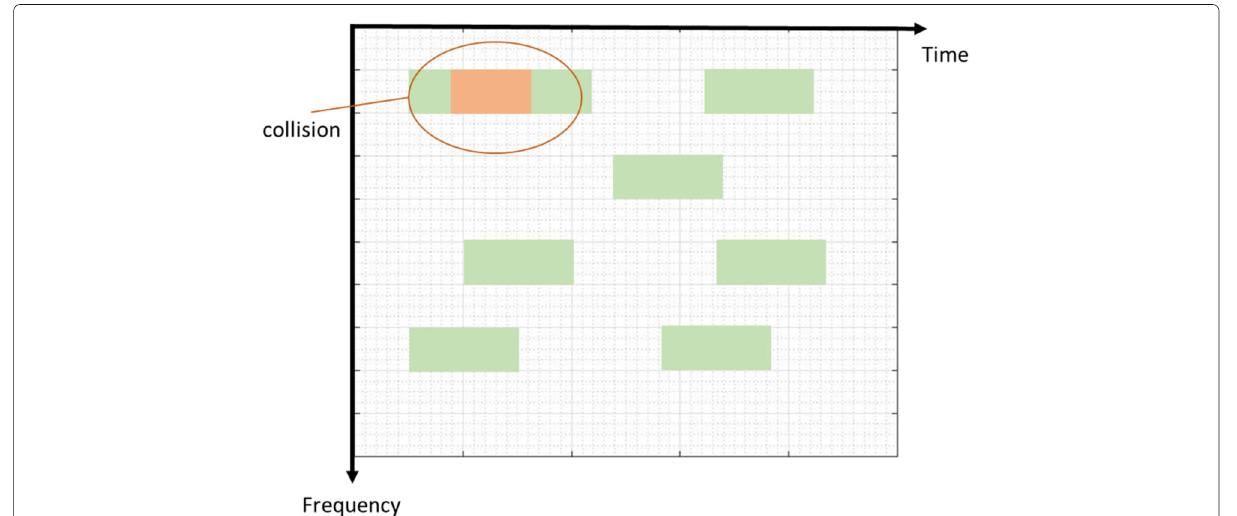
Fig. 2 Collision between two packets in the same frequency